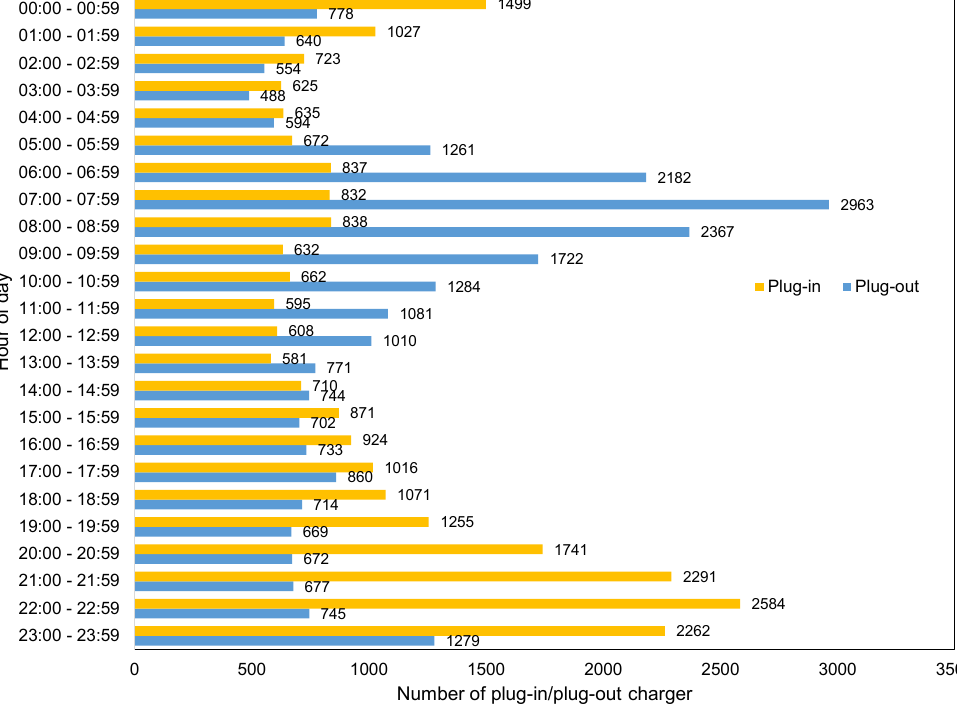
Figure 5. Plug-in and unplugging frequency based on the time of the